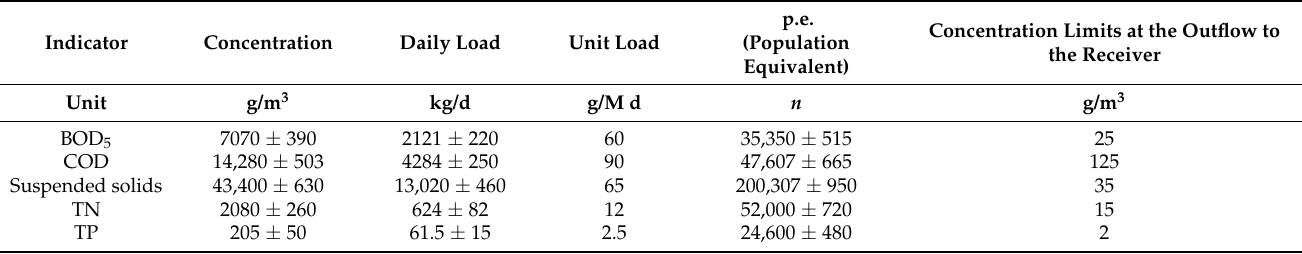
Table 2. Typical pollution loads, pollutant limits in the digestate, and concentration limits at the outflow to the receiver.